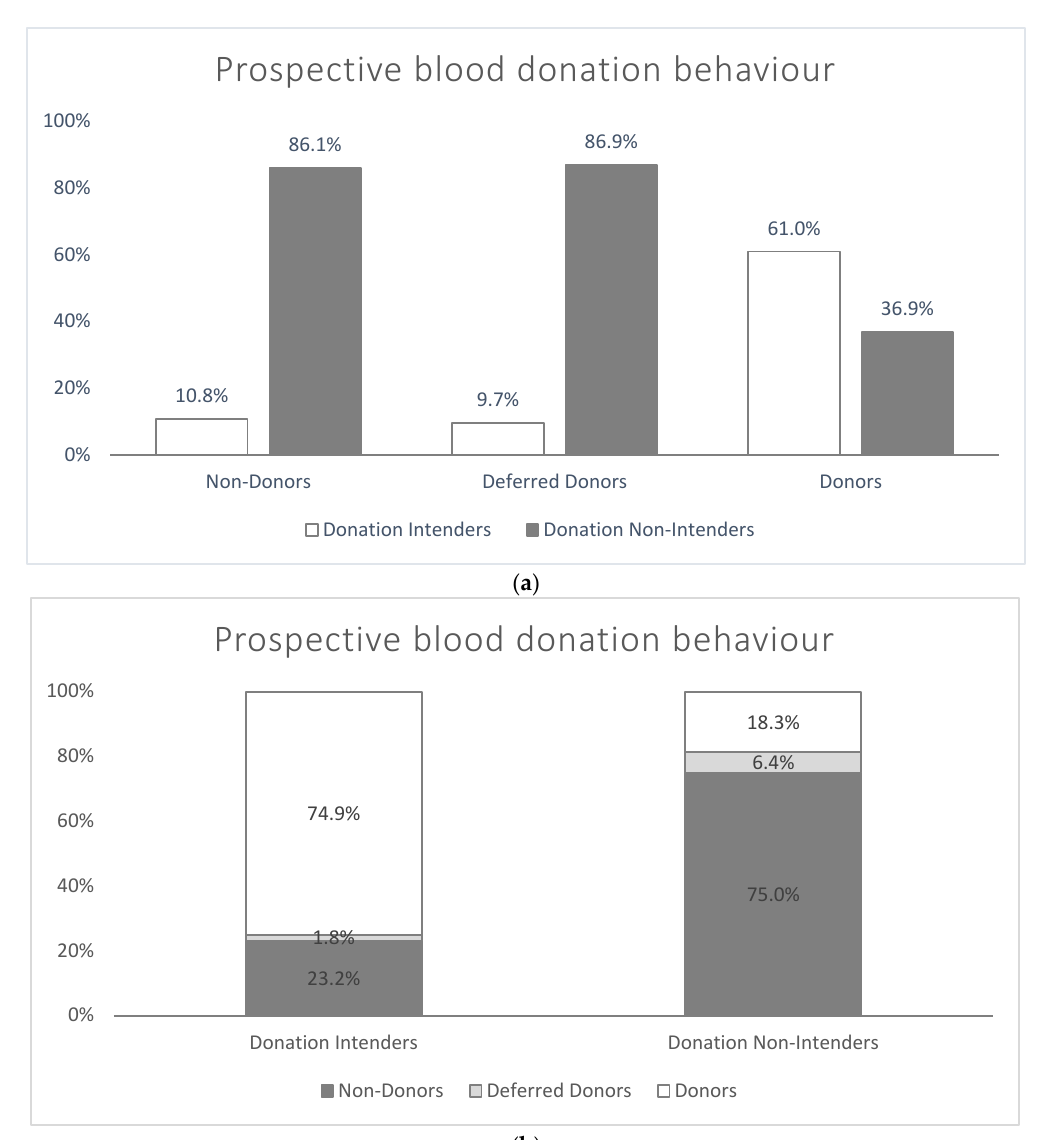
Figure 2. ( a ) Self-reported prospective (12 months) blood donation behaviour (aggregated) depending on blood donation experiences—results for total sample ( n = 2531, weighted). ( b ) Proportions for different types of blood donation experiences as related to prospective (12 months) blood donation intentions—results for total sample ( n = 2531, weighted). Absolute frequencies and cumulative percentages vary as a function of the amount of missing data for each variable.